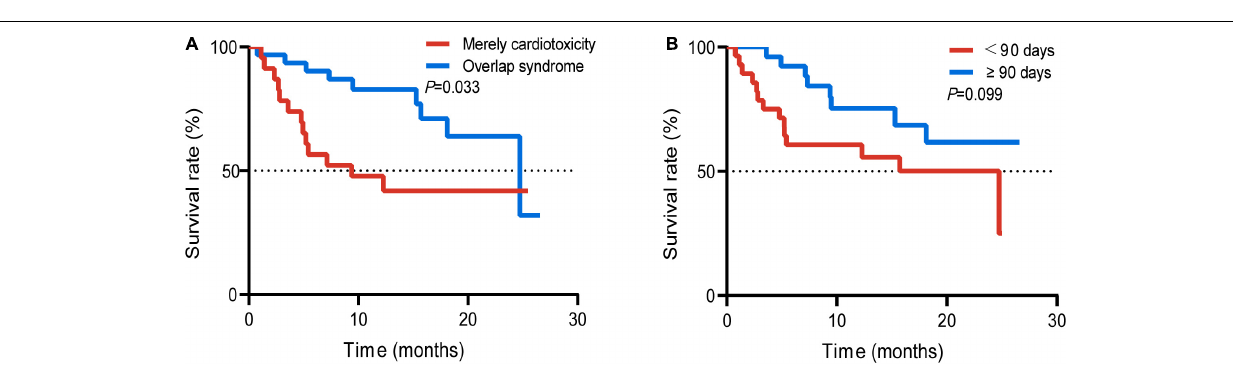
FIGURE 5 | Survival curve of the patients with mere cardiotoxicity and patients with concurrent cardiotoxicity and ICI targeted other functional disorder (A) ; occurrence time (time since ICI initiation to the occurrence of ICI-related cardiotoxicity) of 90 days before and after 90 days (B) .